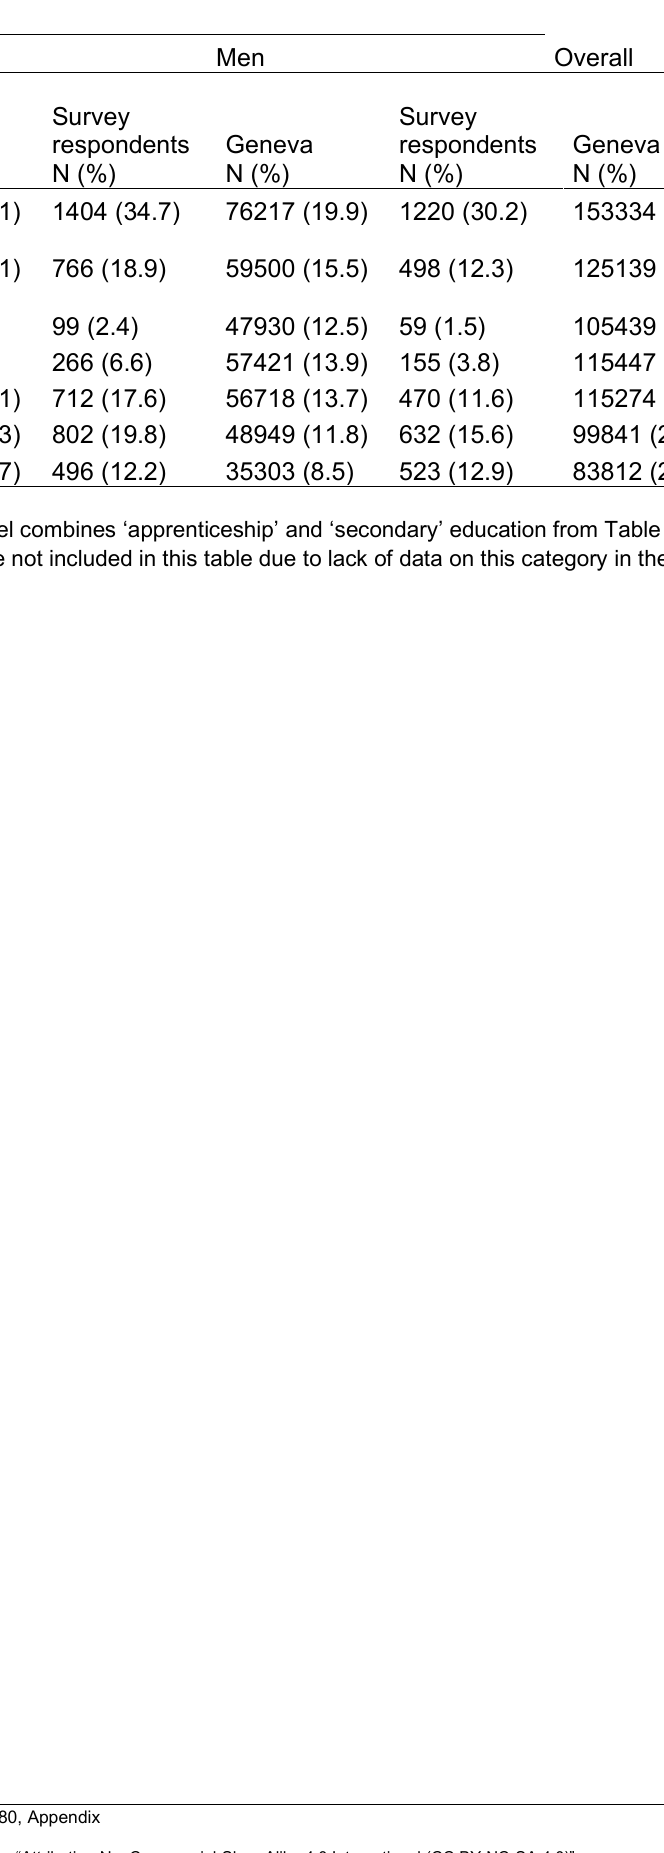
Table S2. Comparison of education level and age category between the Canton of Geneva and the vaccination survey